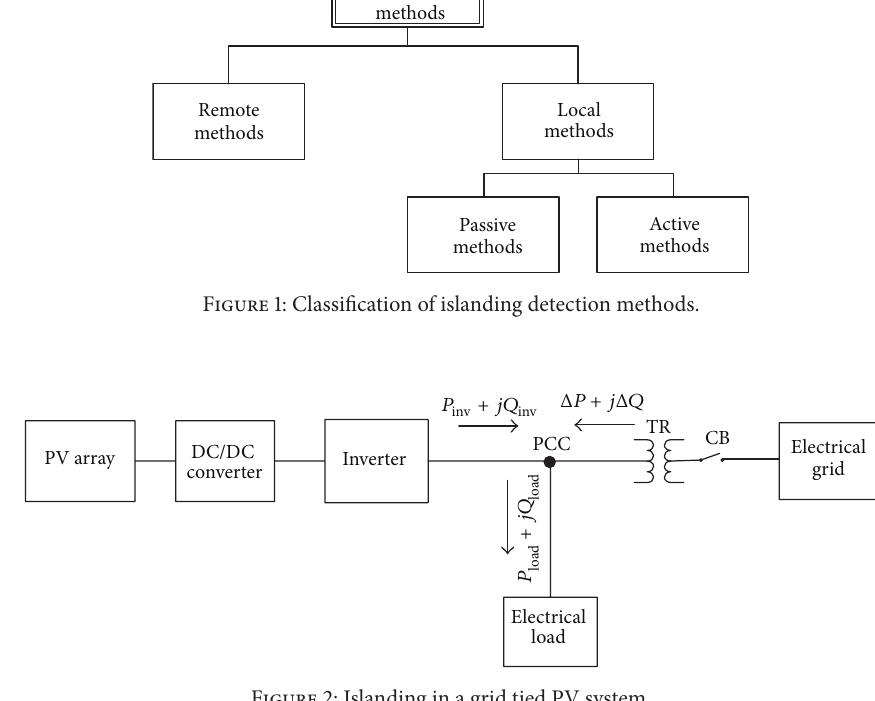
Figure 2: Islanding in a grid tied PV